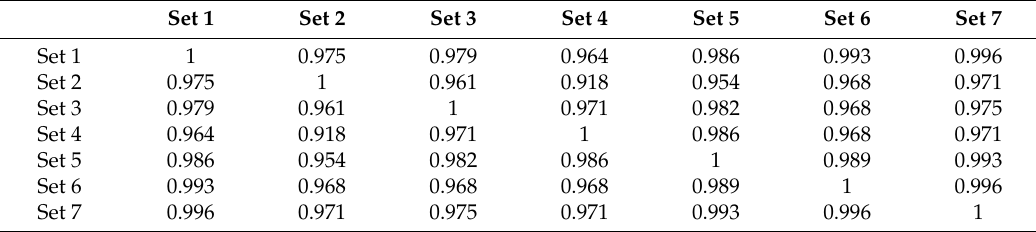
Table 11. The values of Spearman’s correlation coe ffi cient between di ff erent